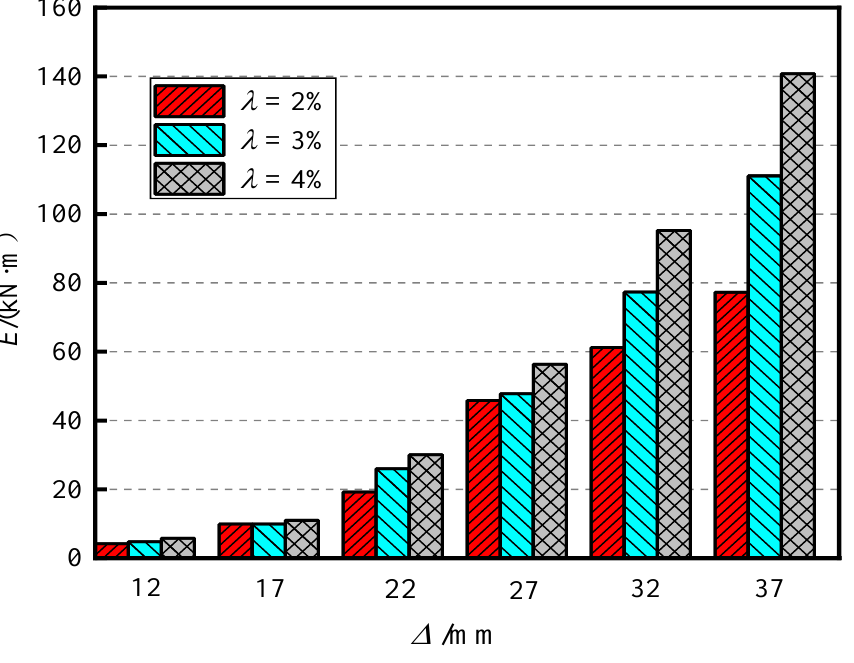
Figure 10. Cumulative energy consumption curve.